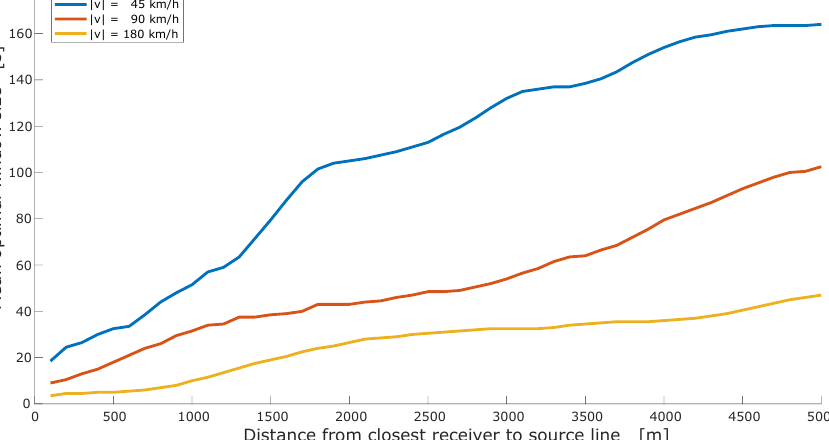
Figure 13. Estimated optimal window size for the random windowing scheme, calculated for trains travelling at 45 km/h, 90 km/h and 180 km/h, in terms of the distance between the receivers and the road (using the closest receiver as reference) and averaged over 30 samples each. The receivers were 400 m apart from each